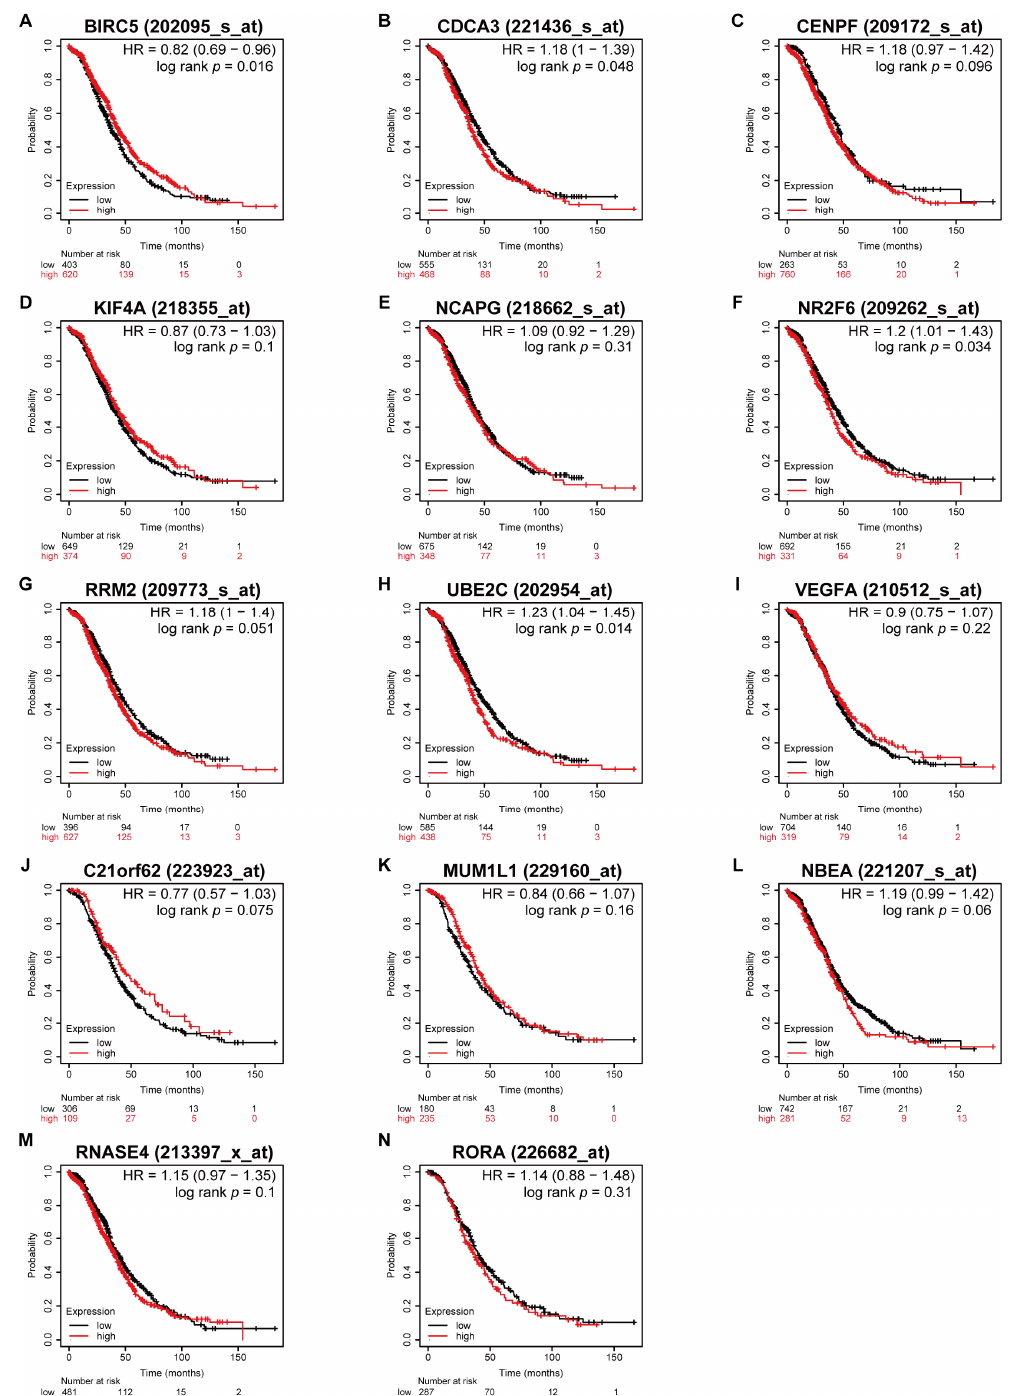
Figure 8. Survival analyses of the dysregulated genes in the advanced stages of serous ovarian can- cer. Kaplan–Meier plots of overall survival in subjects with higher versus lower expression. ( A ) of overall survival in subjects with higher versus lower expression. ( A ) BIRC5 , ( B ) CDCA3 , ( C ) CENPF , ( D ) KIF4A , ( E ) BIRC5 , ( B ) CDCA3 , ( C ) CENPF , ( D ) KIF4A , ( E ) NCAPG , ( F ) NR2F6 , ( G ) RRM2 , ( H ) UBE2C , ( I ) VEGFA , NCAPG , ( F ) NR2F6 , ( G ) RRM2 , ( H ) UBE2C , ( I ) VEGFA , ( J ) C21orf62 , ( K ) MUM1L1 , ( L ) NBEA , ( M ) RNASE4 , and ( N ) RORA ( J ) C21orf62 , ( K ) MUM1L1 , ( L ) NBEA , ( M ) RNASE4 , and ( N ) RORA mRNA expression. mRNA